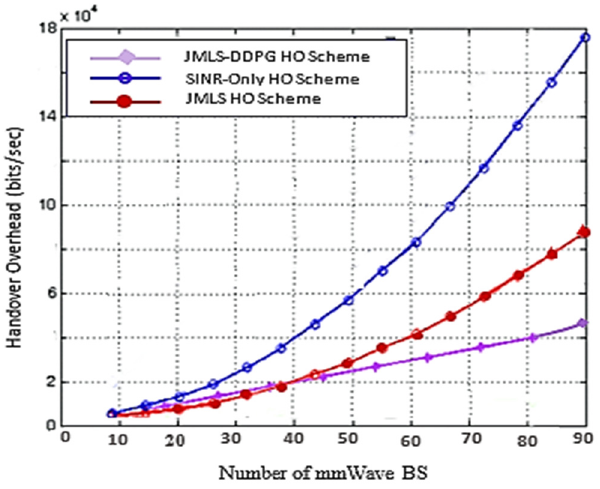
Figure 12. Overhead as a function of the number of mmWave BSs.